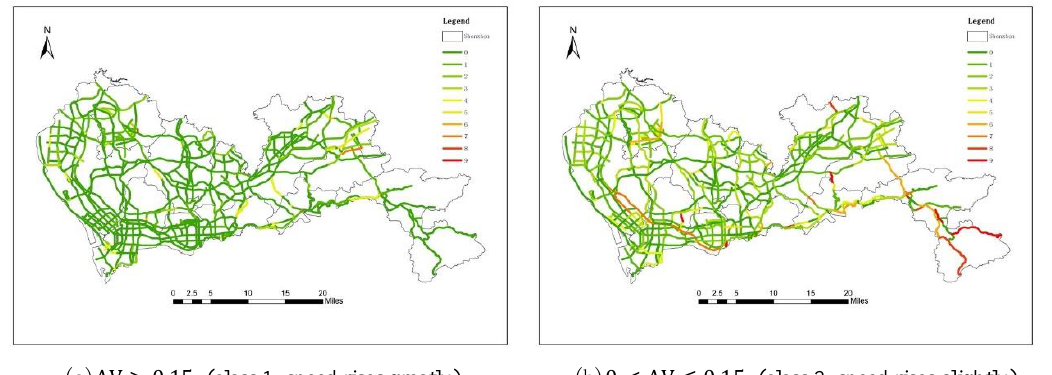
Figure 2. Road speed variation classification (one